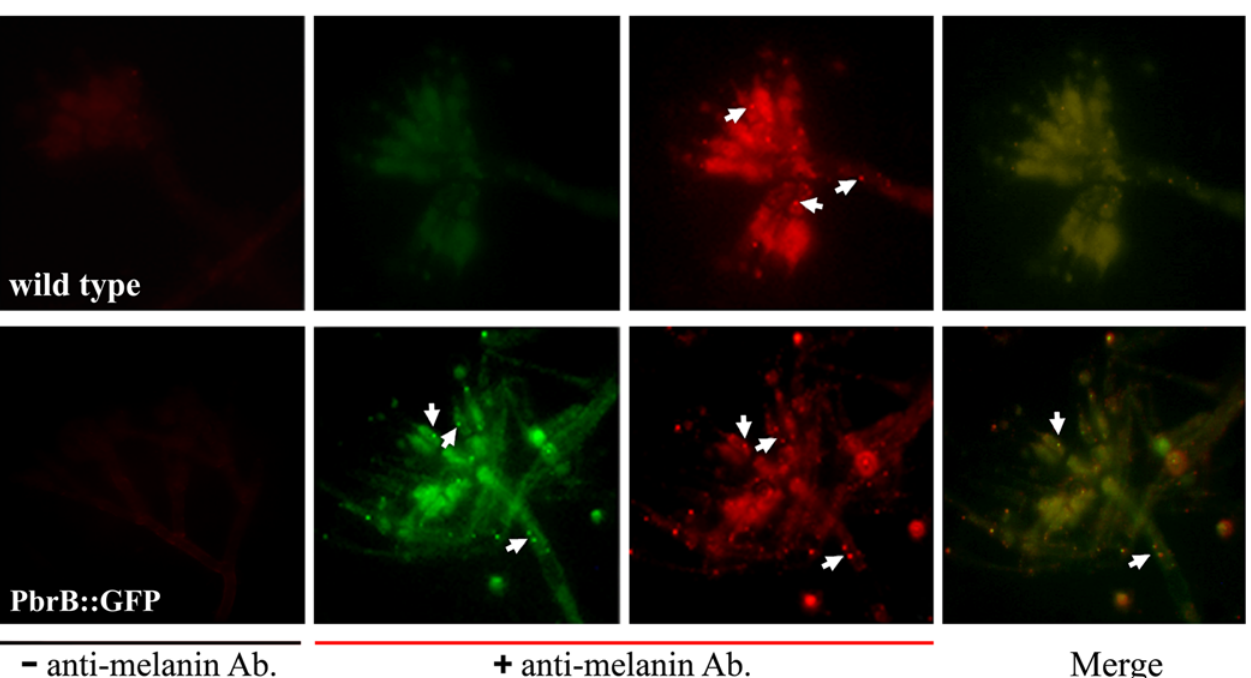
Fig 4. Localization of PbrB and melanin during conidiation in T . marneffei . Epifluorescence microscopy after immunostaining using an anti-melanin antibody staining for the wild type control (G681) and the PbrB::GFP fusion strain after growth on slides at 28°C for 10 days. To assess non-specific staining by the rhodamine-labeled secondary antibody (goat anti-mouse IgM antibody), samples were processed without the primary anti-melanin antibody step (labeled as — anti-melanin Ab.). Red fluorescent signals of melanin or melanin-like particles are observed in both wild type and PbrB::GFP fusion strain (+ anti-melanin Ab.). Green fluorescent signals indicate sites of PbrB::GFP proteins. The merged image shows co-localization of PbrB::GFP and melanin- labeled fluorescence. White arrows identify sites of fluorescence signals which melanin-labeled particles co-localize with PbrB::GFP proteins. Microscopic images were captured at 1000X magnification.